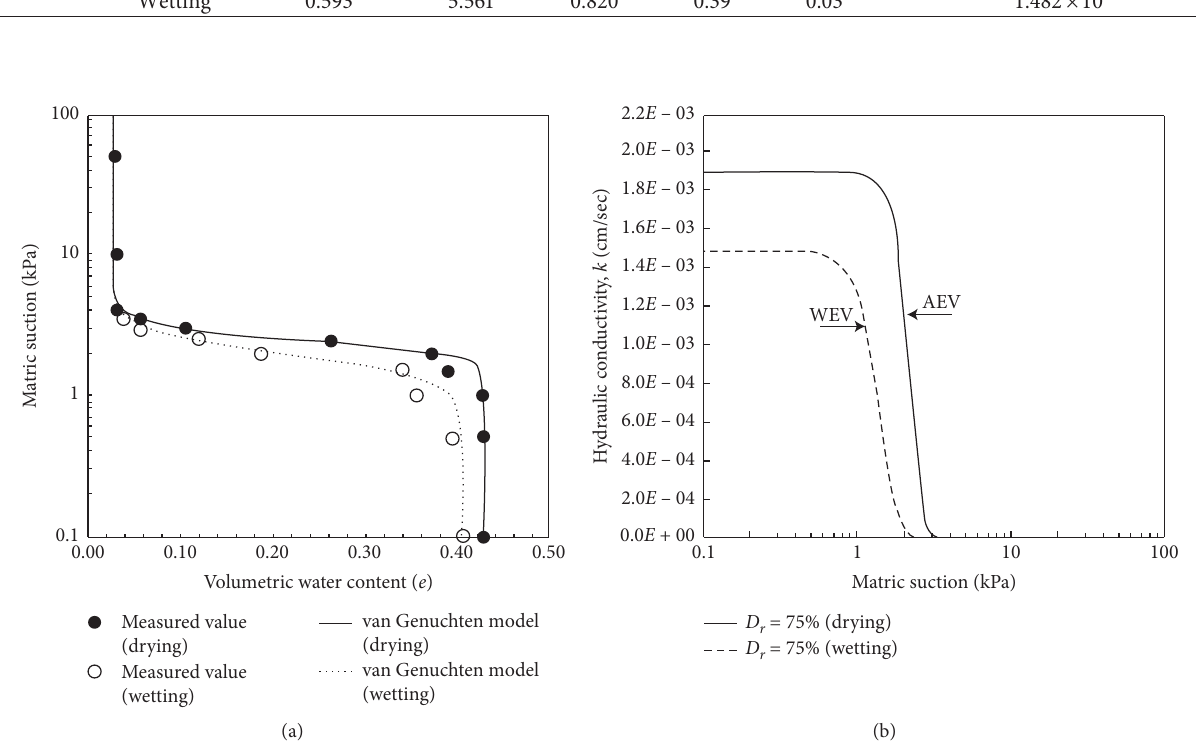
Figure 4: Unsaturated properties of Jumunjin standard sand with a relative density of 75% [17]. (a) SWCC. (b) Unsaturated hydraulic conductivity function.